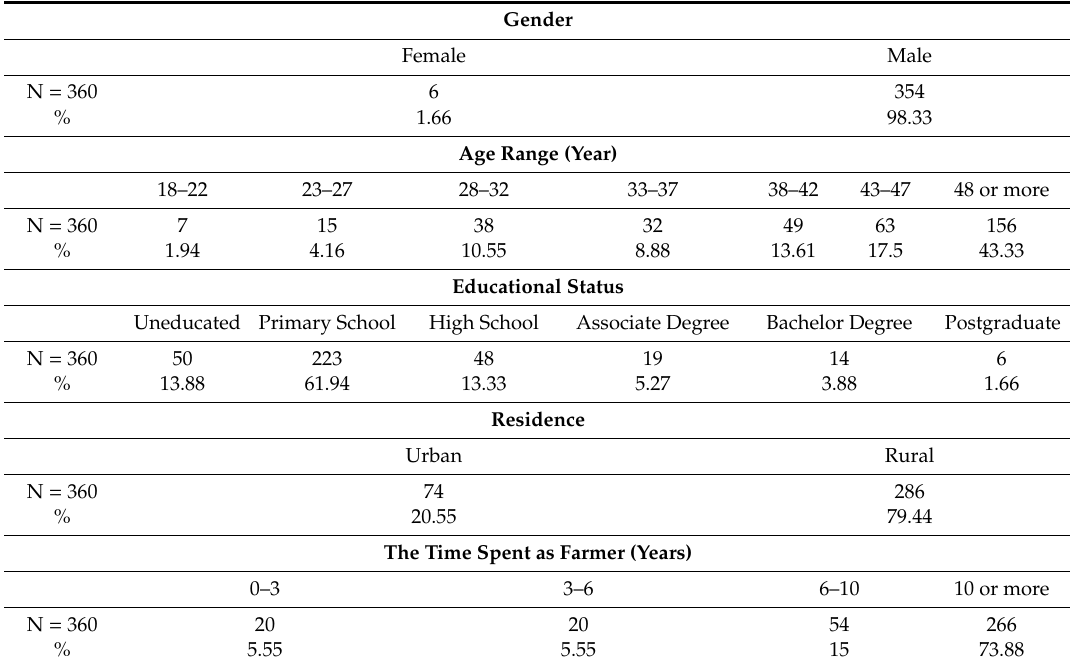
Table 1. Demographic data of farmers participating in the